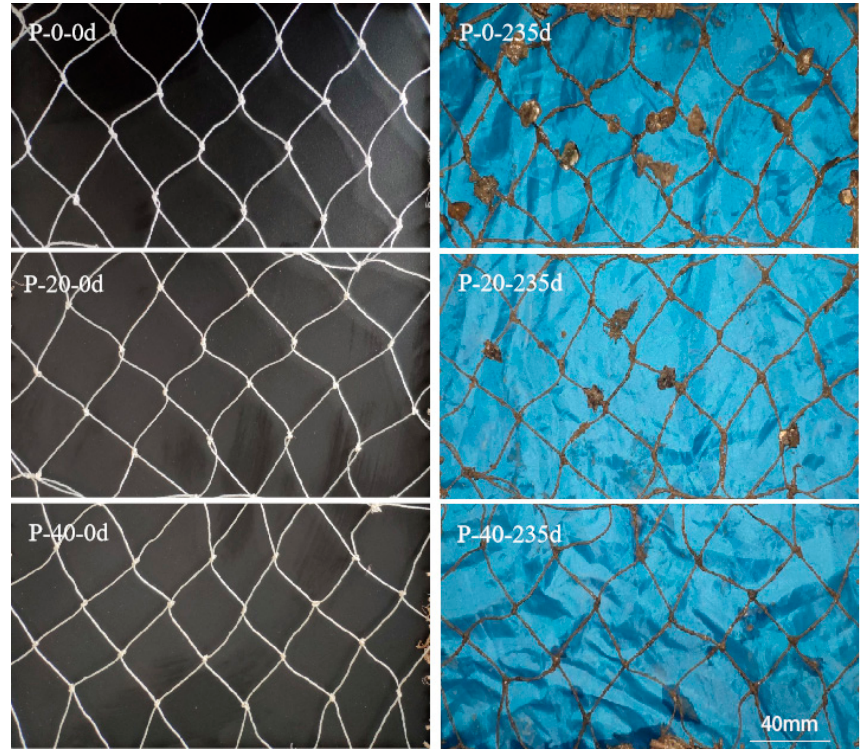
Figure 10. A comparison of biofouling evolution on different fishing netting materials for marine fish farming. Meshes were submerged for 235 days in the East China Sea.